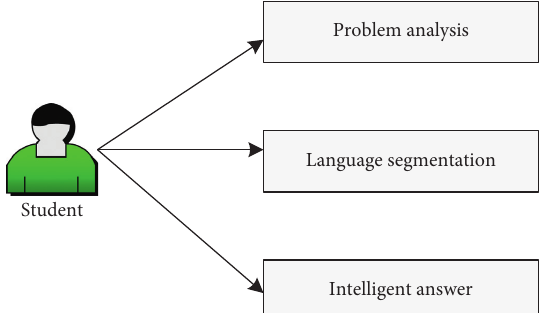
Figure 7: The main function of the intelligent teaching assistant